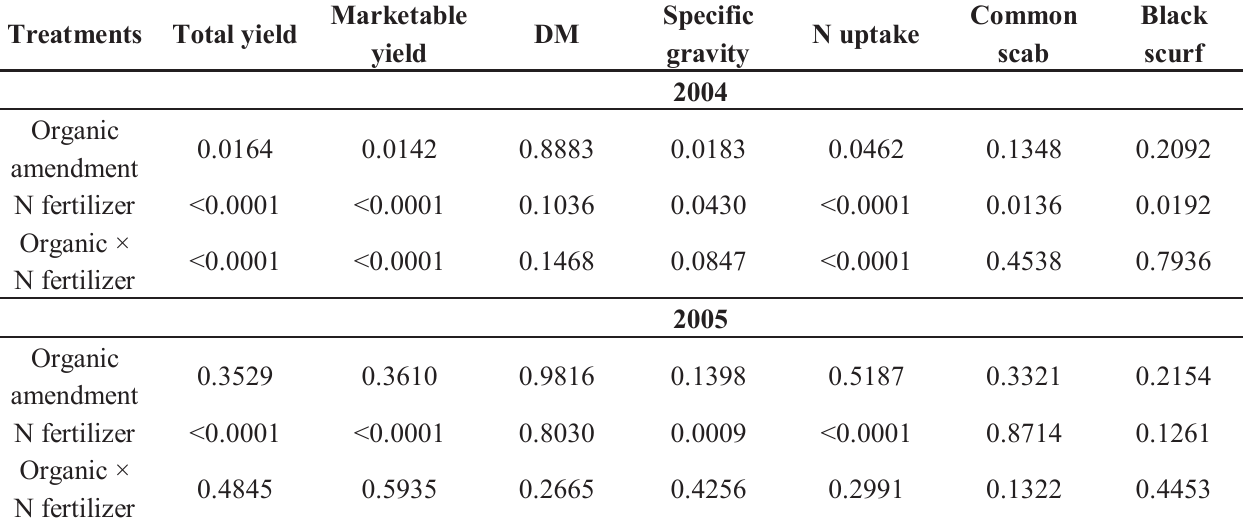
Table 2. Analysis of variance of the effects of organic amendment application with or without reduced N fertilizer on potato yield, N uptake and disease incidence ( P